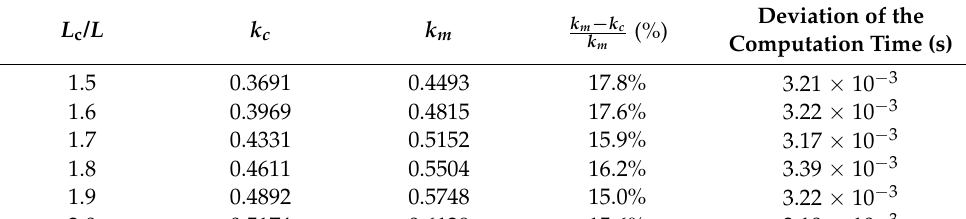
Table 4. The effective thermal conductivity in circle pores compared with the EMT method.